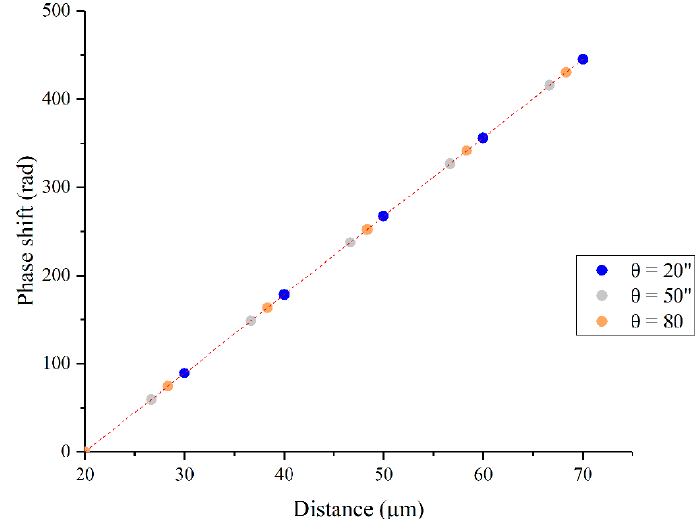
Figure 3. Angular motion error. Table 1. Calibration results of the linear coefficient c.